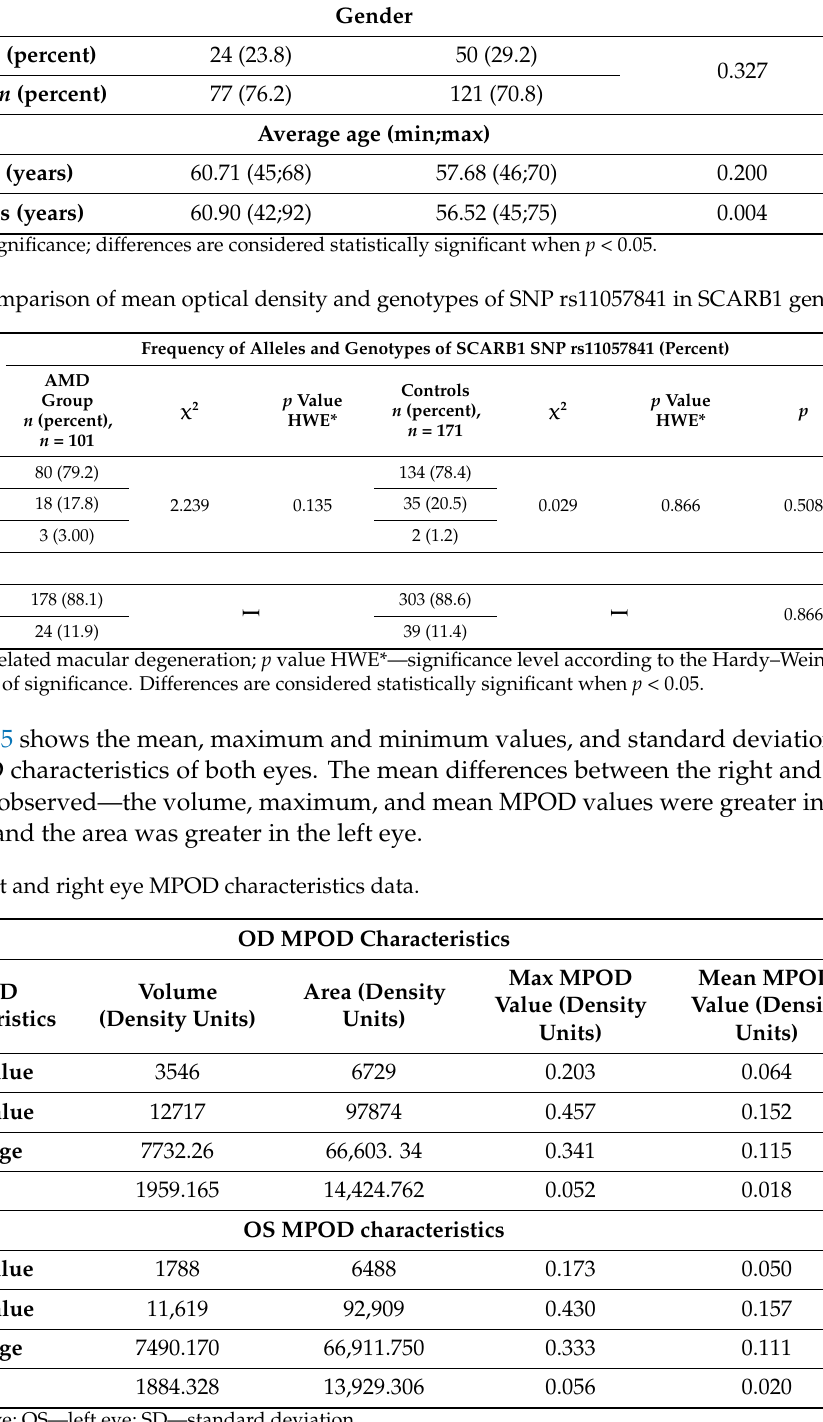
Table 3. Comparison of mean optical density and genotypes of SNP rs11057841 in SCARB1 gene. Samples